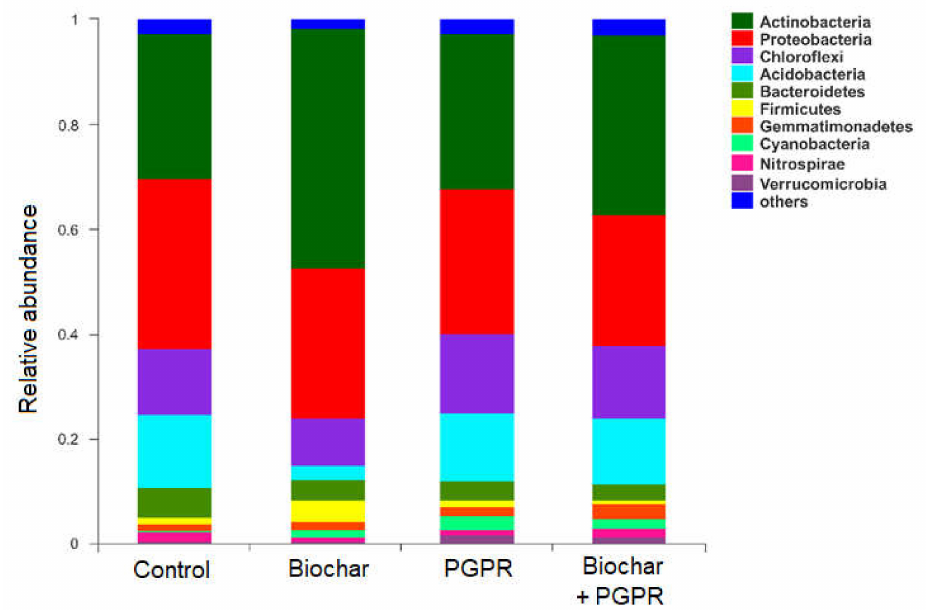
Figure 1. Relative abundances and community compositions of dominant bacterial phylum in soils for each